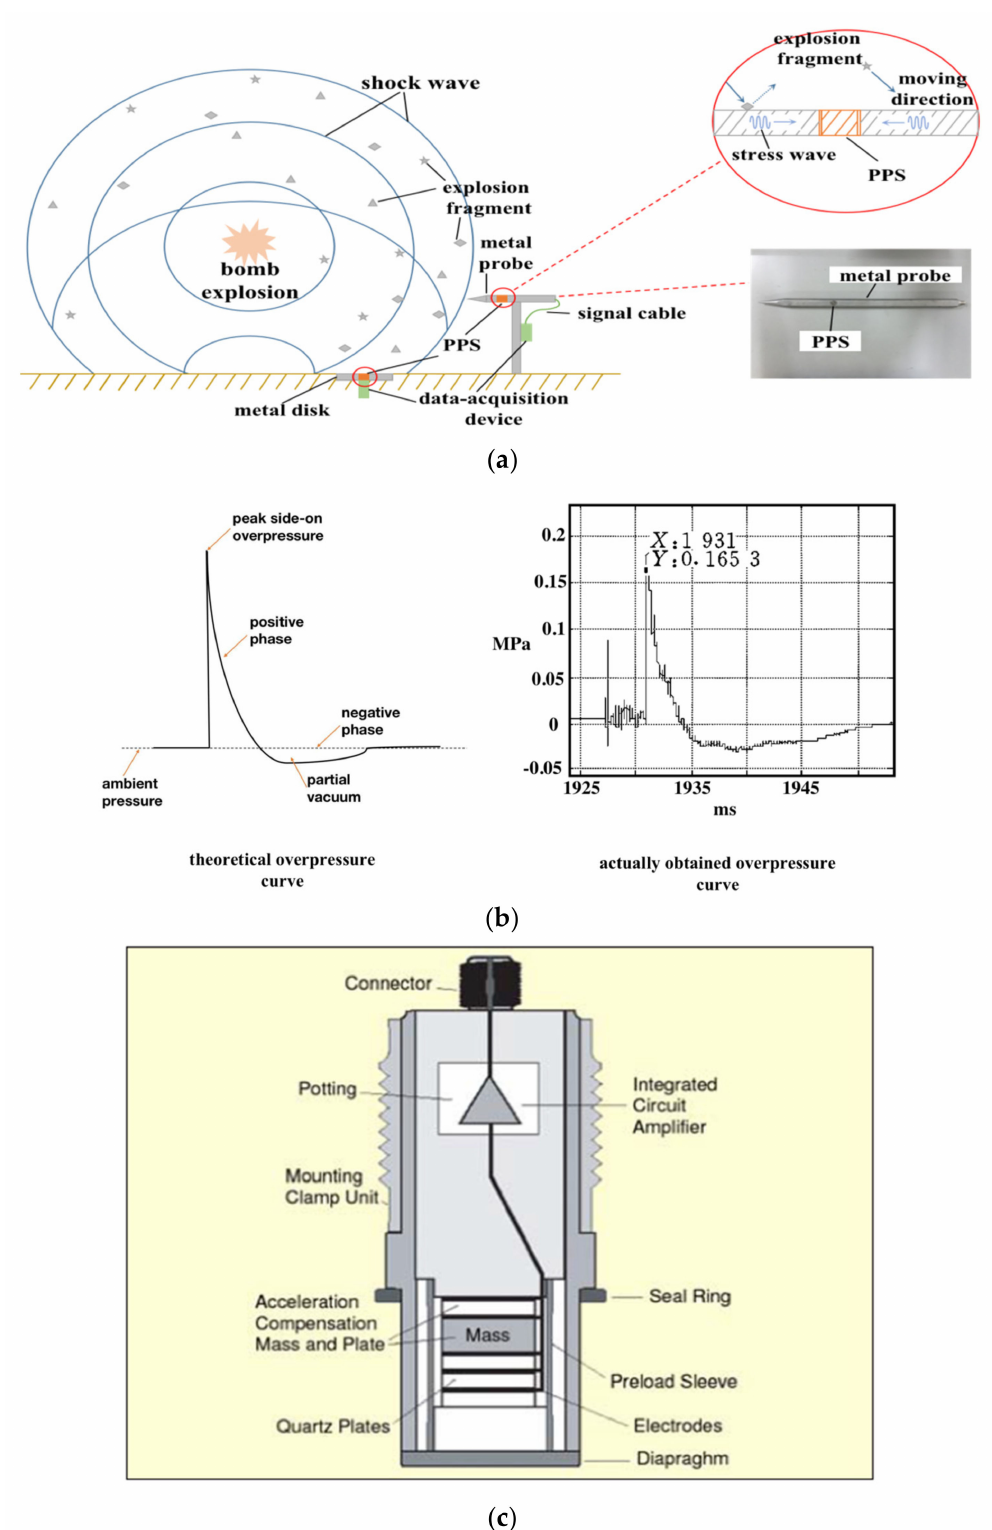
Figure 1. Schematic diagram of a typical explosion shock wave overpressure measurement: ( a ) side on overpressure measurement schematic diagram; ( b ) theoretical and actual side on overpressure curves; ( c ) internal structure of the piezoelectric pressure sensor